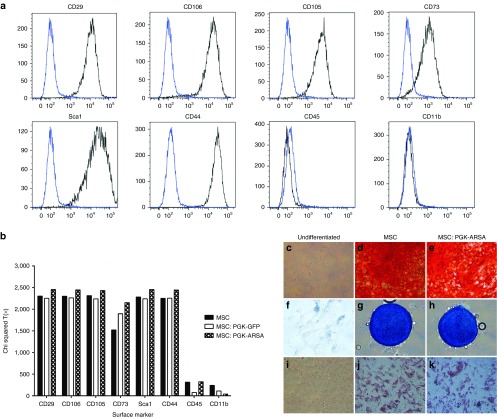
mMSC characteristics are not perturbed by foamy virus vector (FVV) transduction. (a) A panel of antibodies was used to test surface marker expression on mMSCs transduced or not with FVV. Representative plots (using mMSCs transduced with FVV:PGK-ARSA) are shown comparing isotype control antibody staining (blue) to staining with the antibody indicated above each plot (black). (b) The difference between isotype control and surface marker antibody signal intensity was quantified using the FlowJo Chi-squared T(x) comparison and plotted for untransduced MSCs (black), or mMSCs transduced with either FVV:PGK-GFP (white) or FVV:PGK-ARSA (diamond patterned). Higher values of T(x) show greater difference between surface marker antibody and the isotype control. (c–k) Representative photomicrographs are shown for mMSCs stained with Alizarin Red (c–e), Alcian Blue (f–h) or Oil Red O (i–k) without inducing differentiation (c,f,i) or after culturing in osteogenic (d,e), chondrogenic (g,h), or adipogenic (j,k) differentiation medium. mMSCs were untransduced or transduced with FVV-PGK-ARSA at a MOI of 30 as indicated.